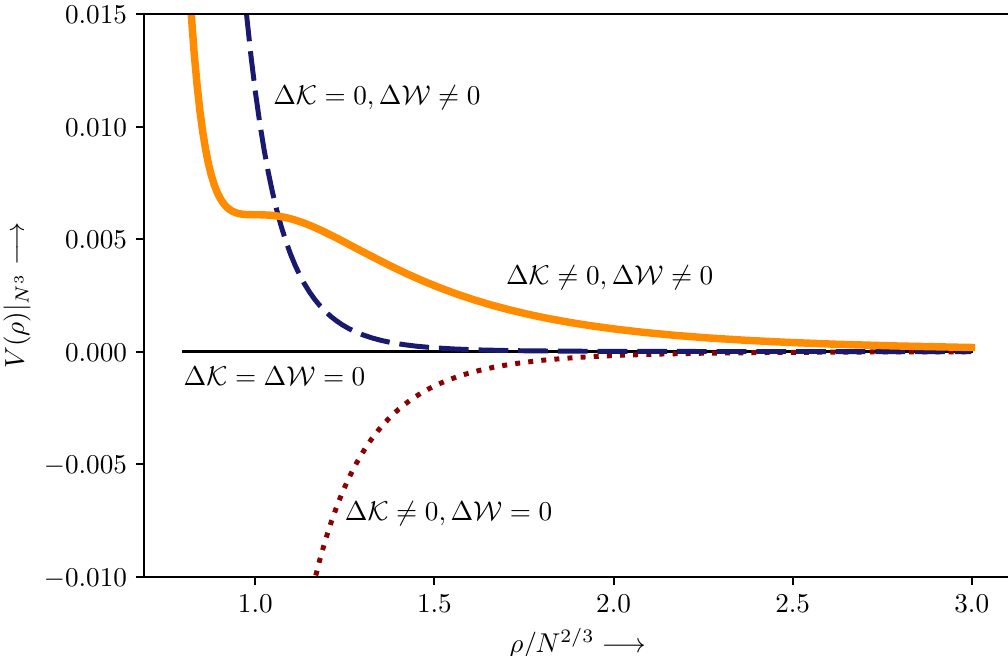
3 )) along the volume modulus ρ . The potential generated Figure 1 . Potential (truncated to O ( N − by the higher curvature term in the K¨ahler potential is shown with the red dotted line and that of the additional terms in the superpotential is shown with the dashed blue line. The parameters in ∆ and ∆ can be chosen so that the total potential, represented by the thick orange line, has a K W metastable dS